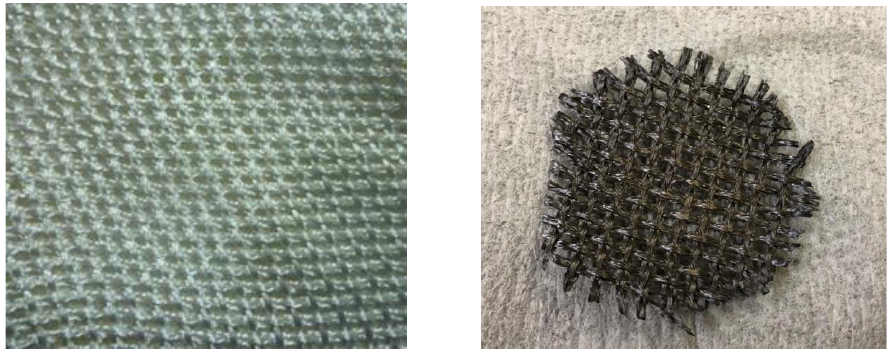
/ TiO 2 (left: Before; right: